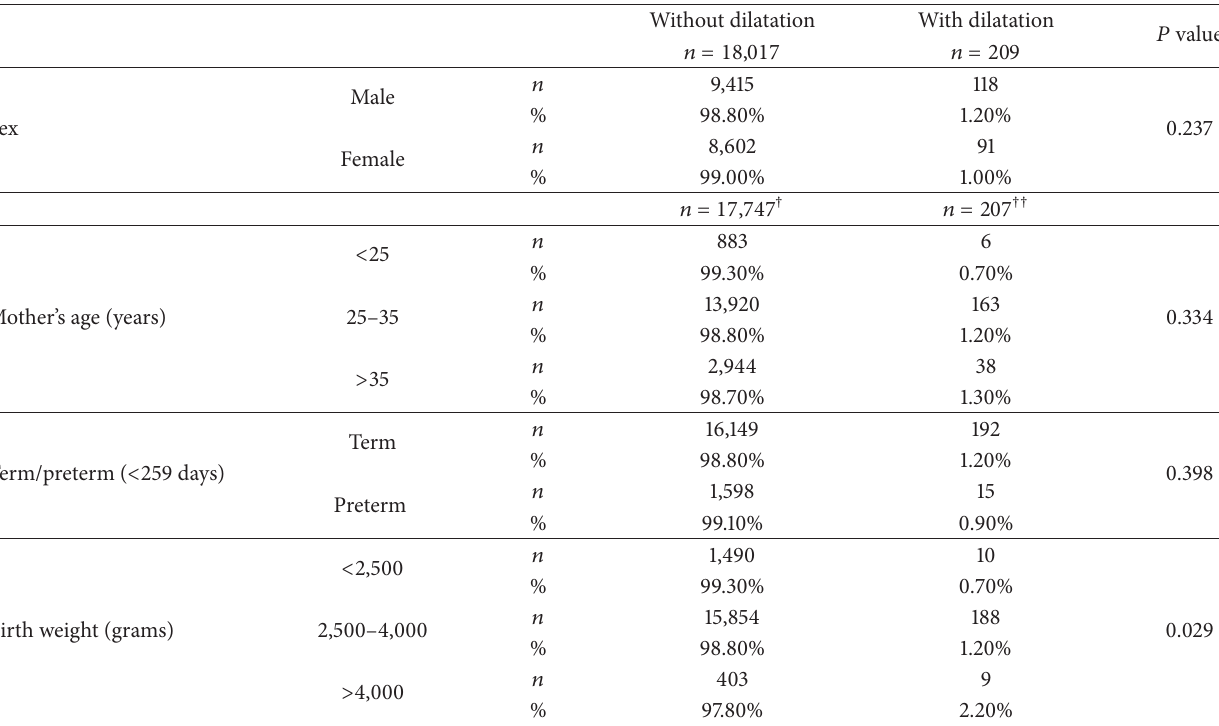
Table 1: Predictive factors of fusiform CBD dilatation ∗ .